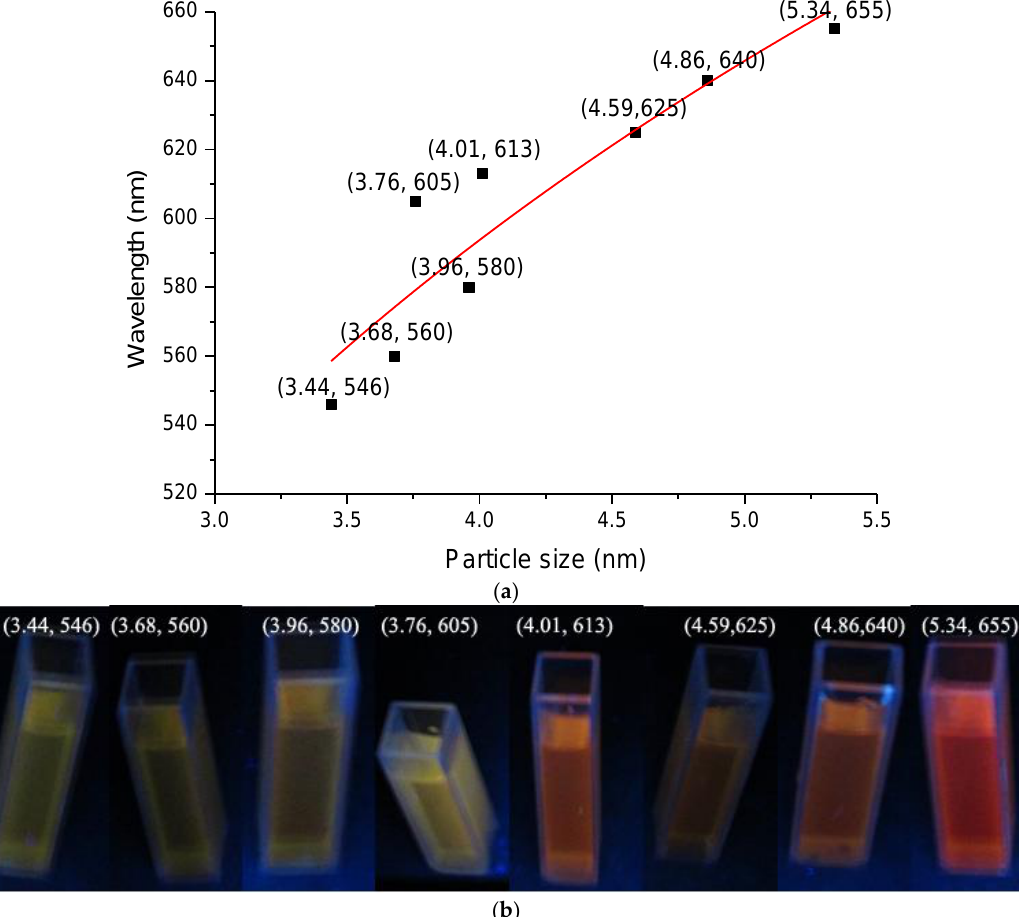
Figure 9. ( a ) The effect of CdS quantum dot size on the PL performance; and ( b ) the fluorescence images of the CNF/CdS nanocomposites under different CdS quantum dot sizes.